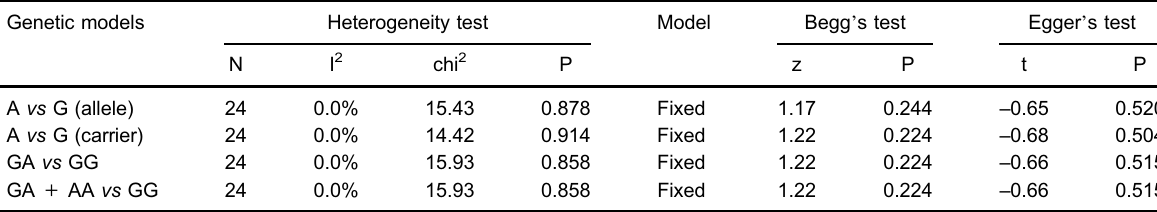
Table 1. Heterogeneity test and publication bias analysis. Genetic models